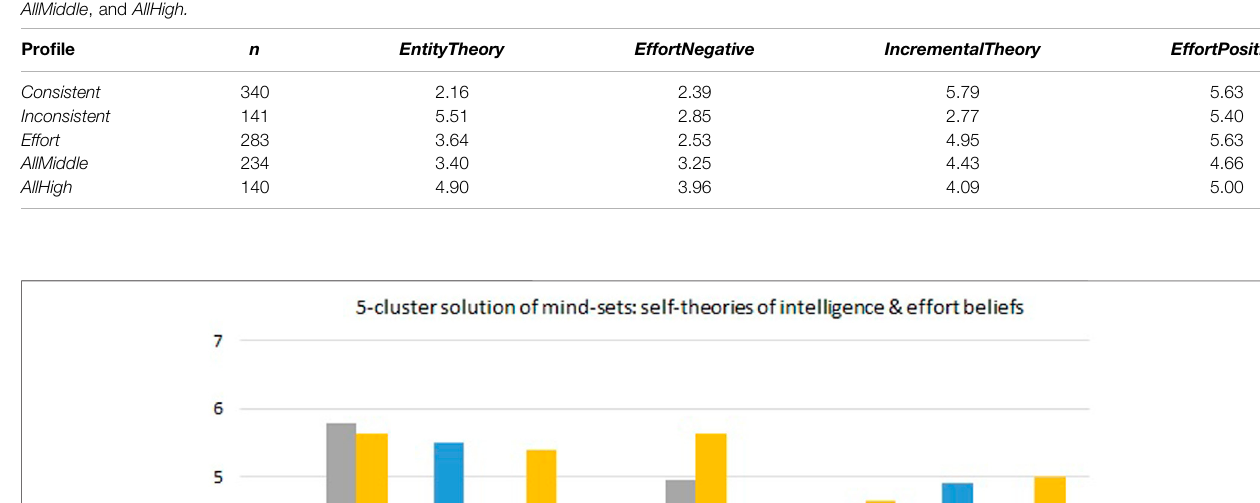
Frontiers in Education |